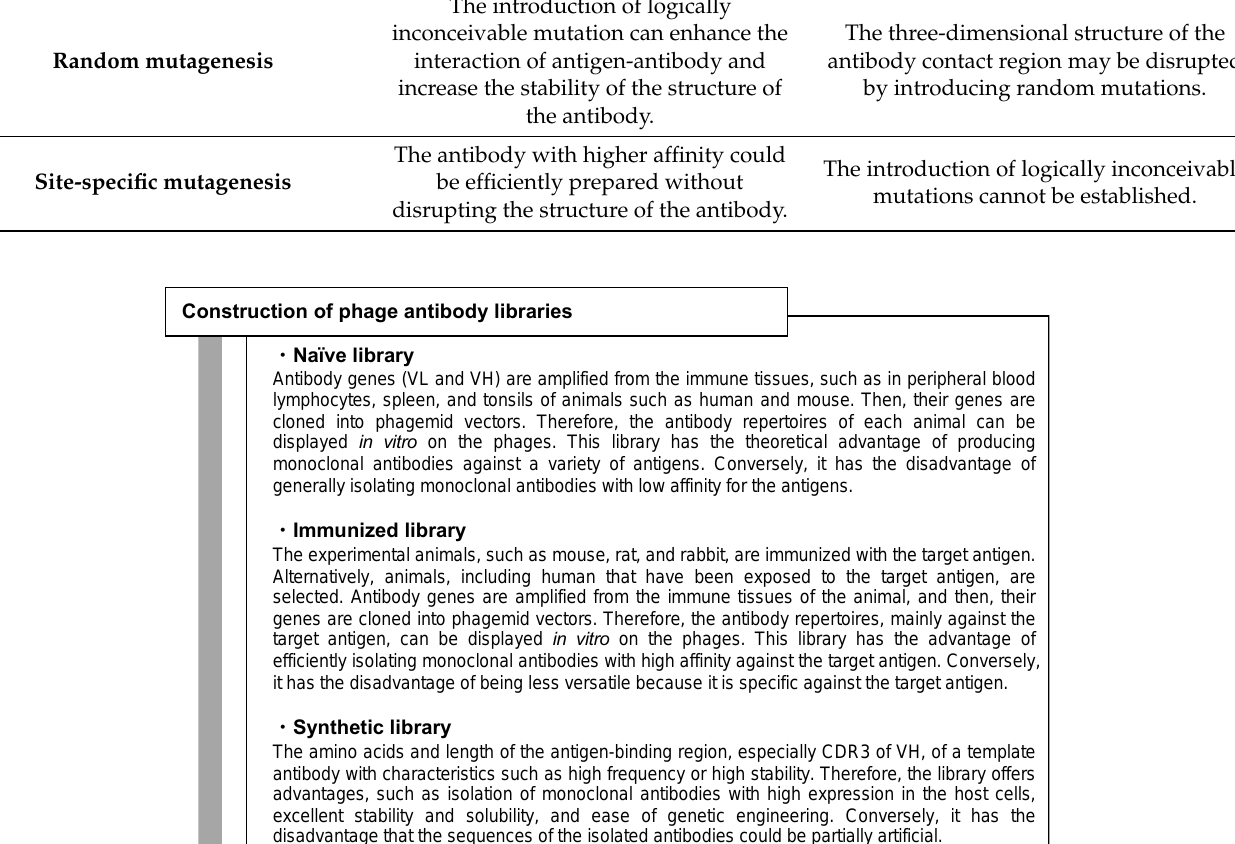
Phage antibody library